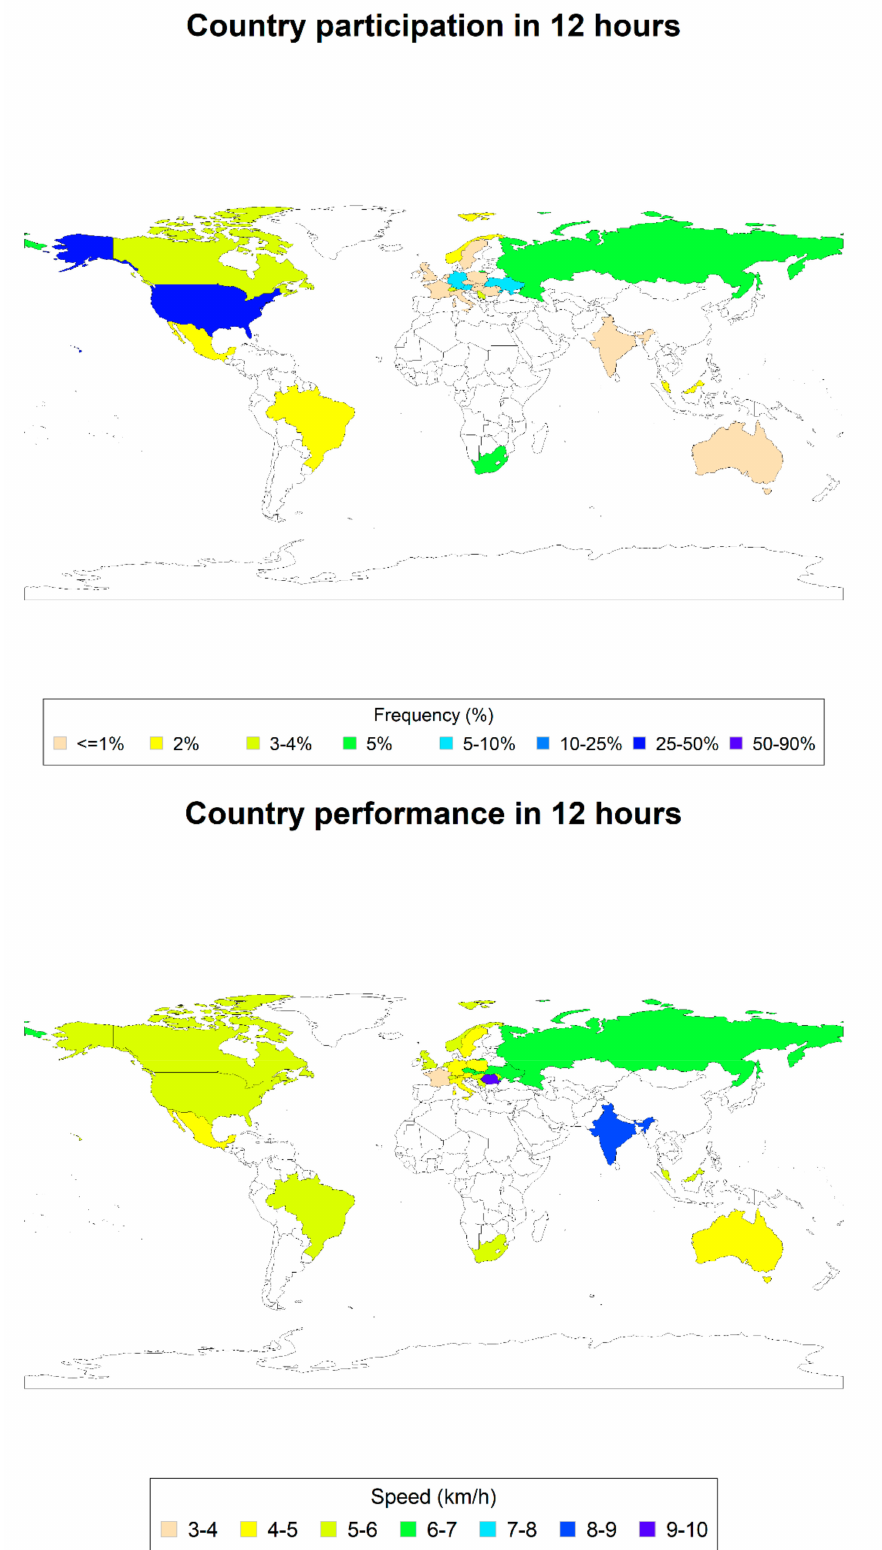
Figure 2. Participation (%) and average performance (km / h) by nationality in 12-h